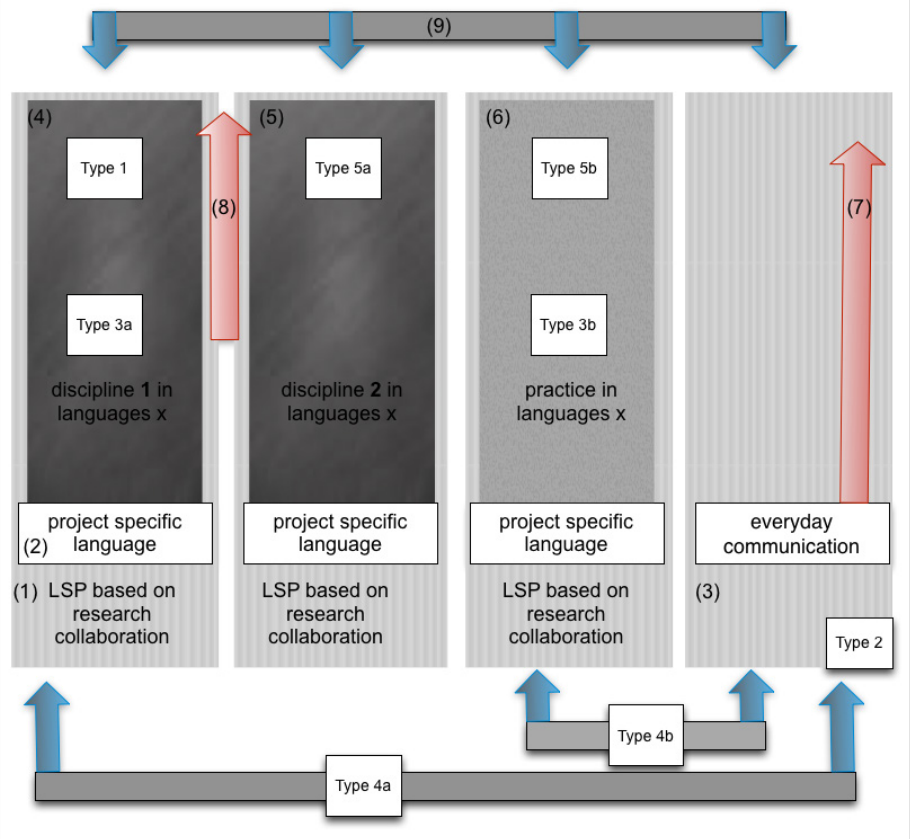
Fig. 6: vertical structuring of project communication focusing on the communication